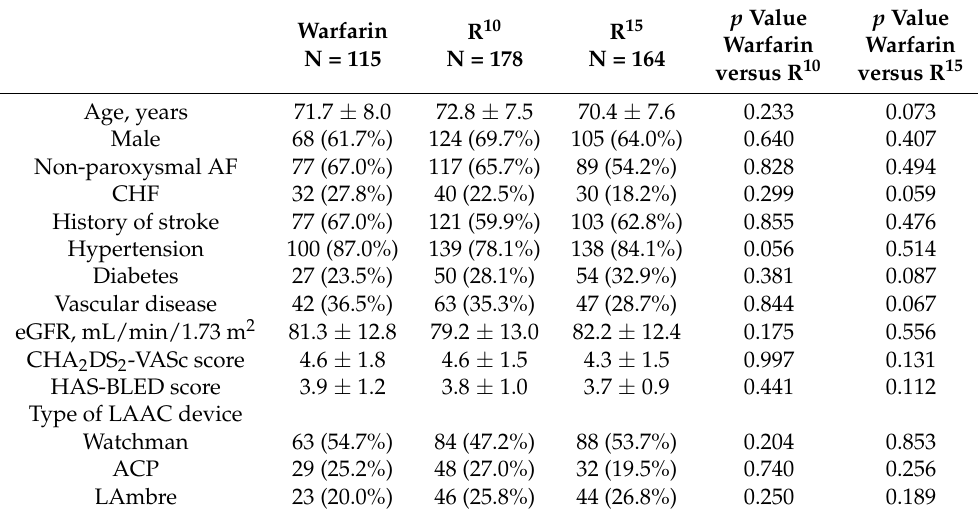
Table 2. Baseline patient characteristics stratified by warfarin, reduced-dose, and half-dose rivaroxaban. Warfarin